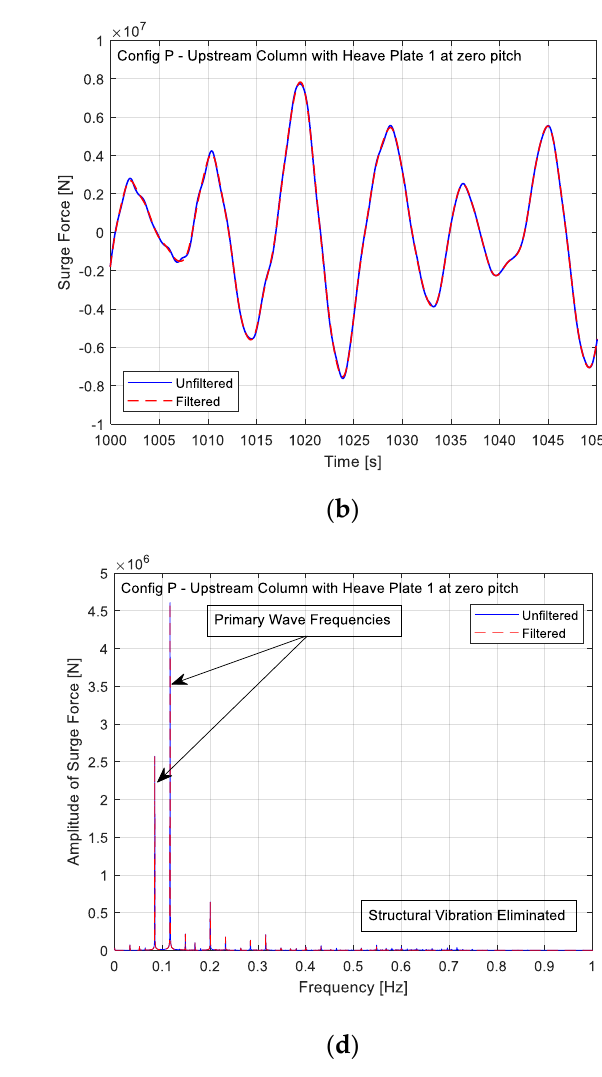
Figure 11. Coordinate-system convention for the surge force 𝐹 𝑥 , heave force 𝐹 𝑧 , and pitch moment 𝑀 𝑦 in the final dataset [6]. The directions of 𝐹 𝑥 , 𝐹 𝑧 , and 𝑀 𝑦 along with the fixed origin about which 𝑀 𝑦 is computed (highlighted in red) remain the same irrespective of the configuration and column. For single column configurations, the column was always placed at the upstream column position. All dimensions are at full scale.